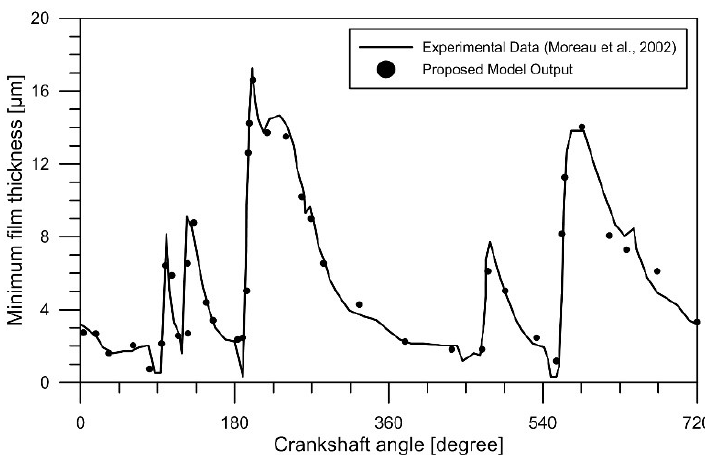
Figure 9. Comparison of values obtained for minimum film thickness.